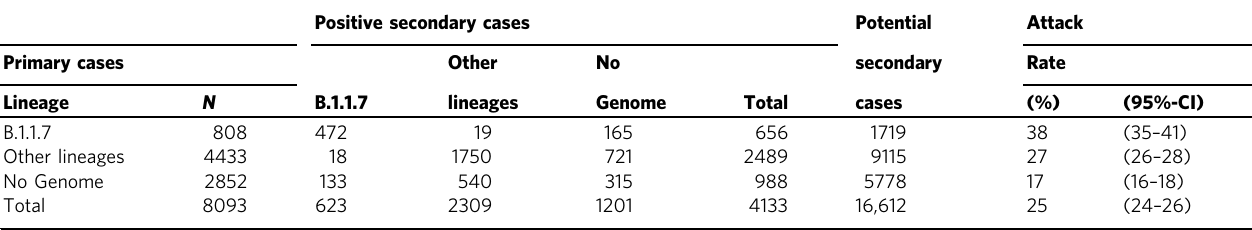
Table 2 Intra-household correlation of lineages between primary and positive secondary cases.